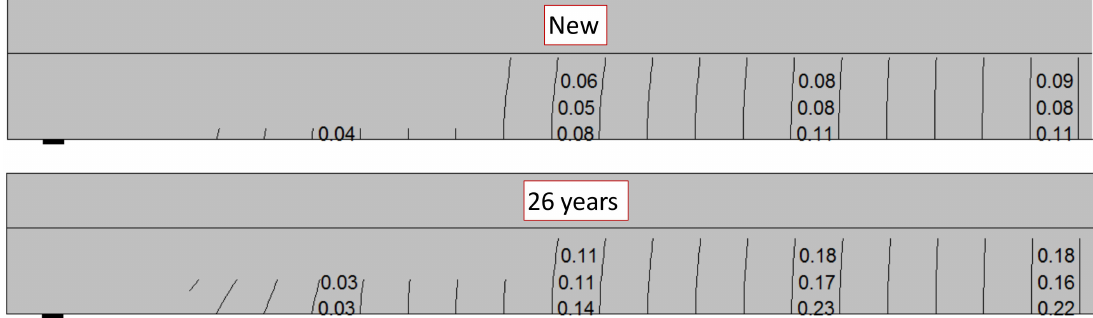
Figure 5. The crack distribution obtained from Response